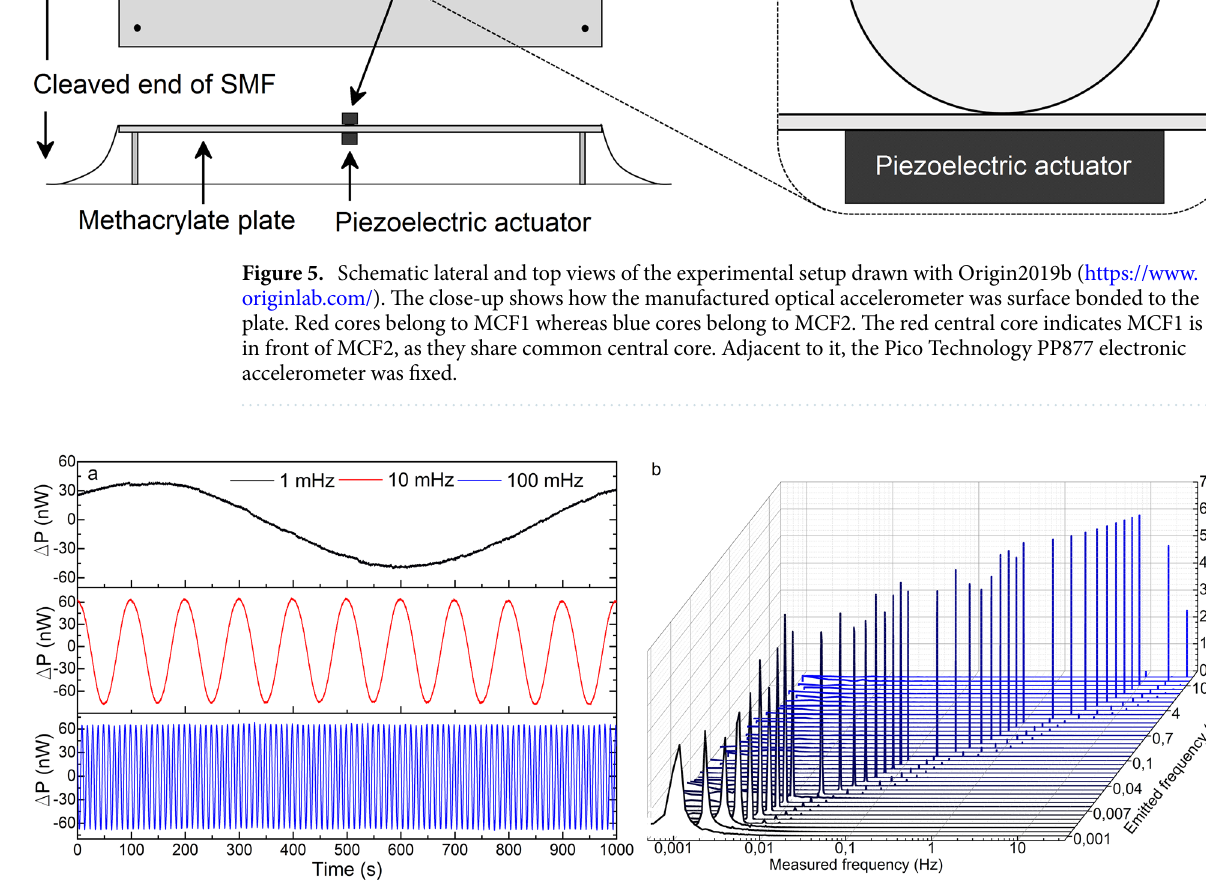
Figure 6. Results of the power measurements in the manufactured optical device. ( a ) Time response of three representative cases . ( b ) FFT amplitudes for frequencies from 30 Hz down to 1 mHz for a sinusoidal signal of 1 Vpp. The Measured frequency axis is in logarithmic